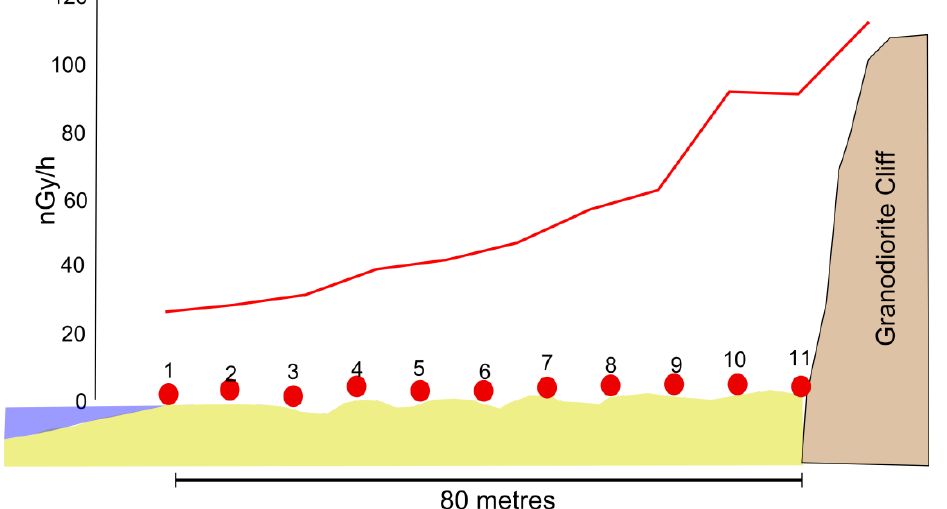
Figure 4. Total gamma counts taken on a beach at the Solway Firth, SW Scotland (54°51′15′′N, 3°40′59′′W). Red dots indicate locations that gamma-ray readings were taken; red line indicates gamma-ray dose rates at each location showing gradual increase in counts as granodiorite cliff